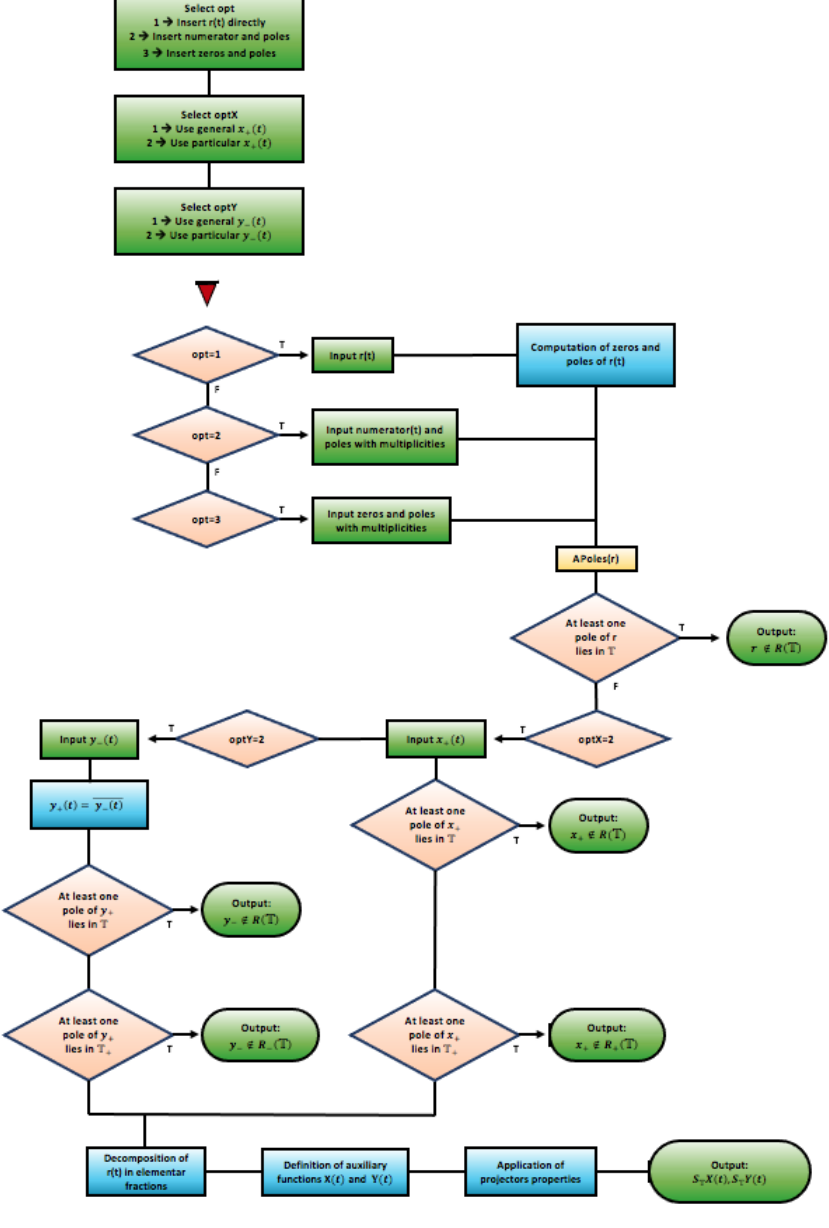
Figure 55. Flowchart of the [SInt] 2.0